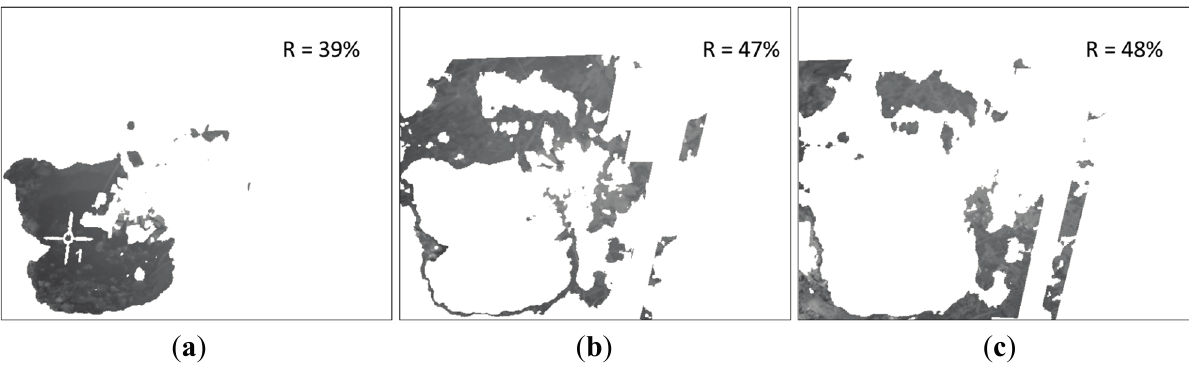
Figure 15. Delimited areas and mean reflectance percentages on the normalised SWIR image. ( a ) First cluster; ( b ) Second cluster; ( c ) Third